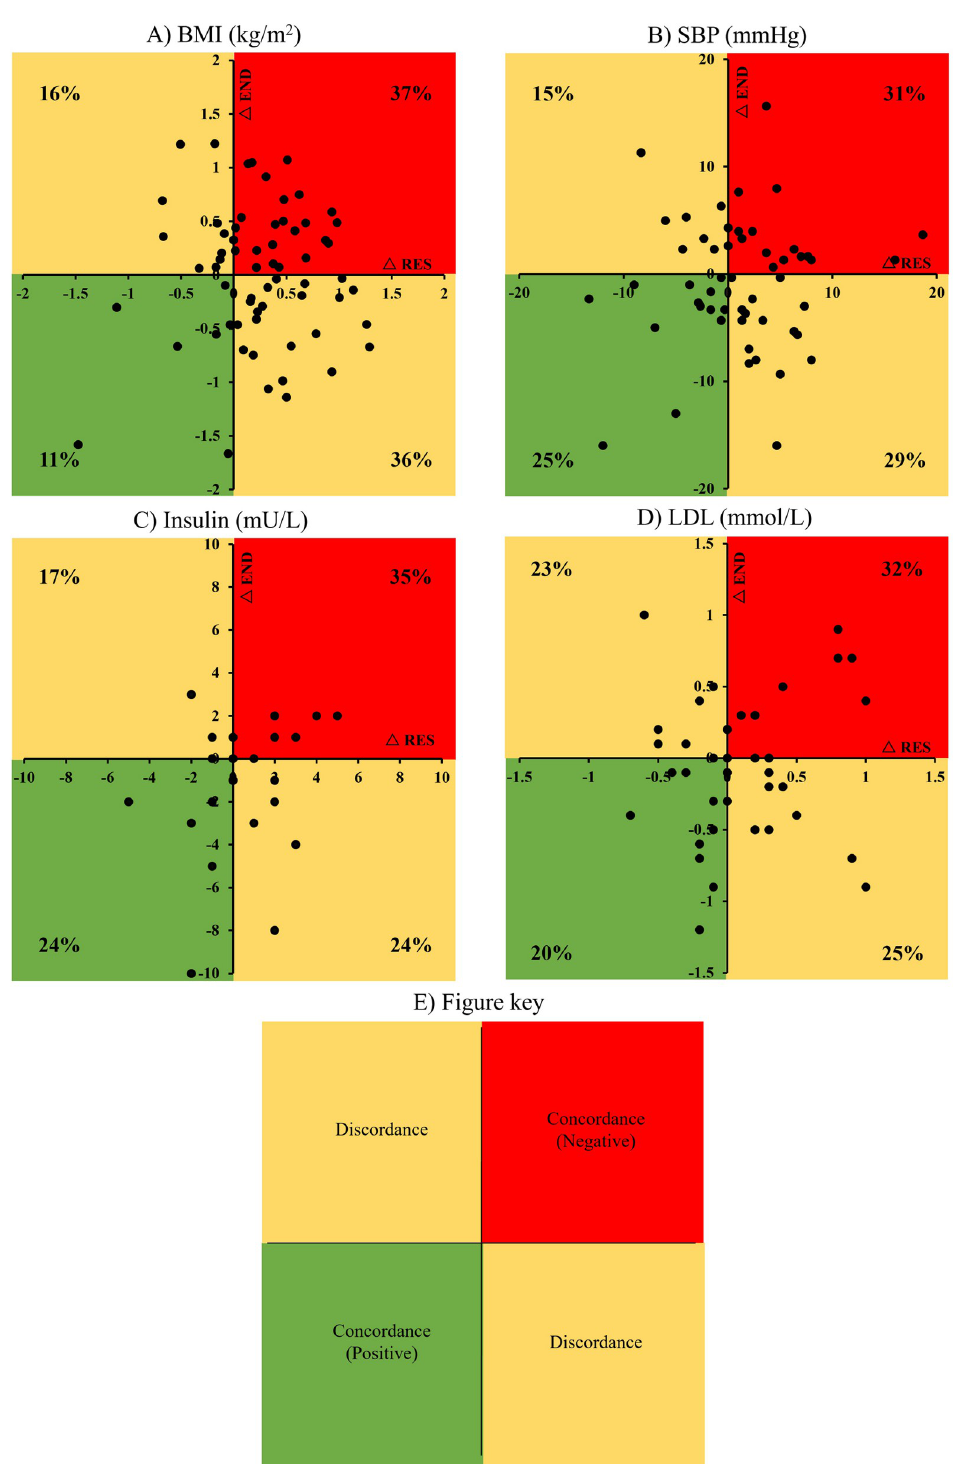
Fig 5. Individual subject exercise intervention change score ( Δ ) data plotted against one another with response to END on the y-axis and RES on the x-axis. BMI is shown in panel A, SBP is shown in panel B, insulin is shown in panel C, and LDL is shown in panel D. A fig key (E) depicts concordance and discordance for response to RES and END with percentages of responders for each quadrant reported for each variable (A–D).